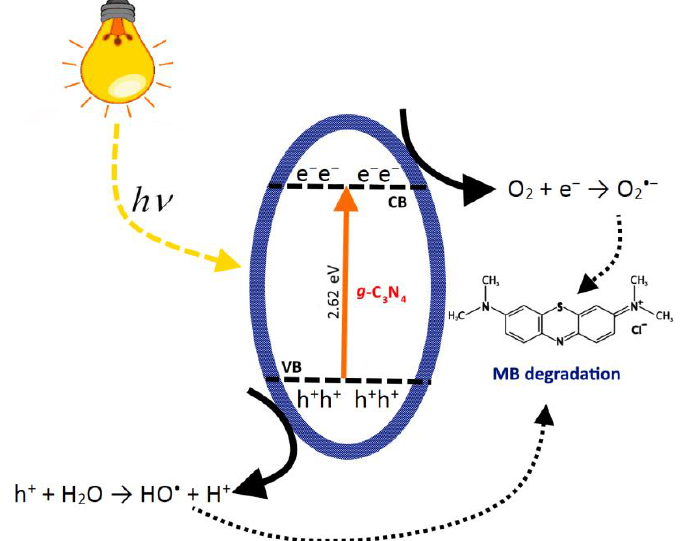
Figure 10. The possible mechanism of the photocatalytic degradation of MB at immobilised g -C 3 N 4 catalyst on the alumina substrate when exposed under simulated solar